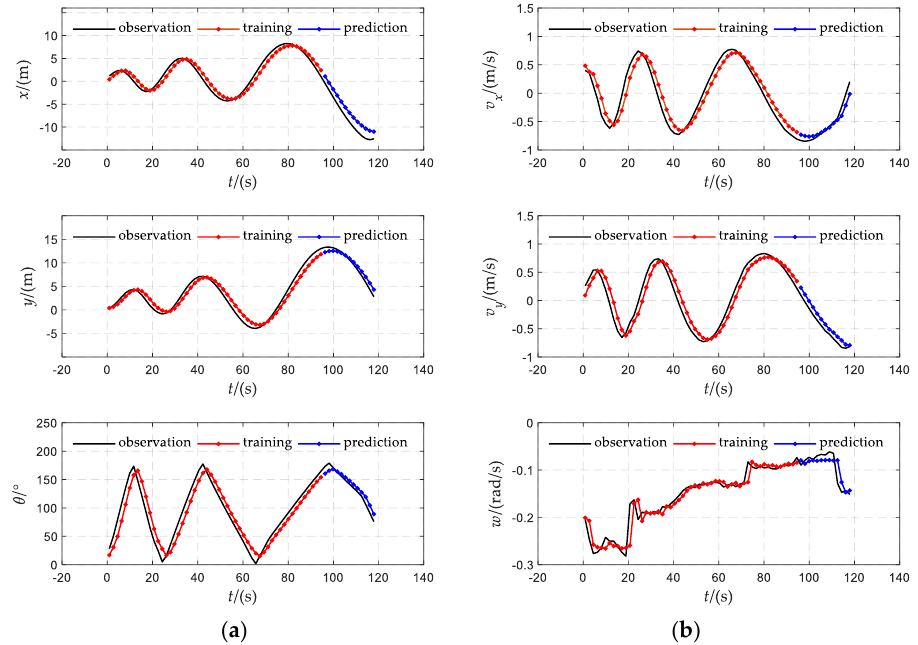
Figure 12. Results of training and prediction of variable driving force. ( a ) Results of training and prediction of position and yall angle; ( b ) Results of training and prediction of velocity and angular velocity.